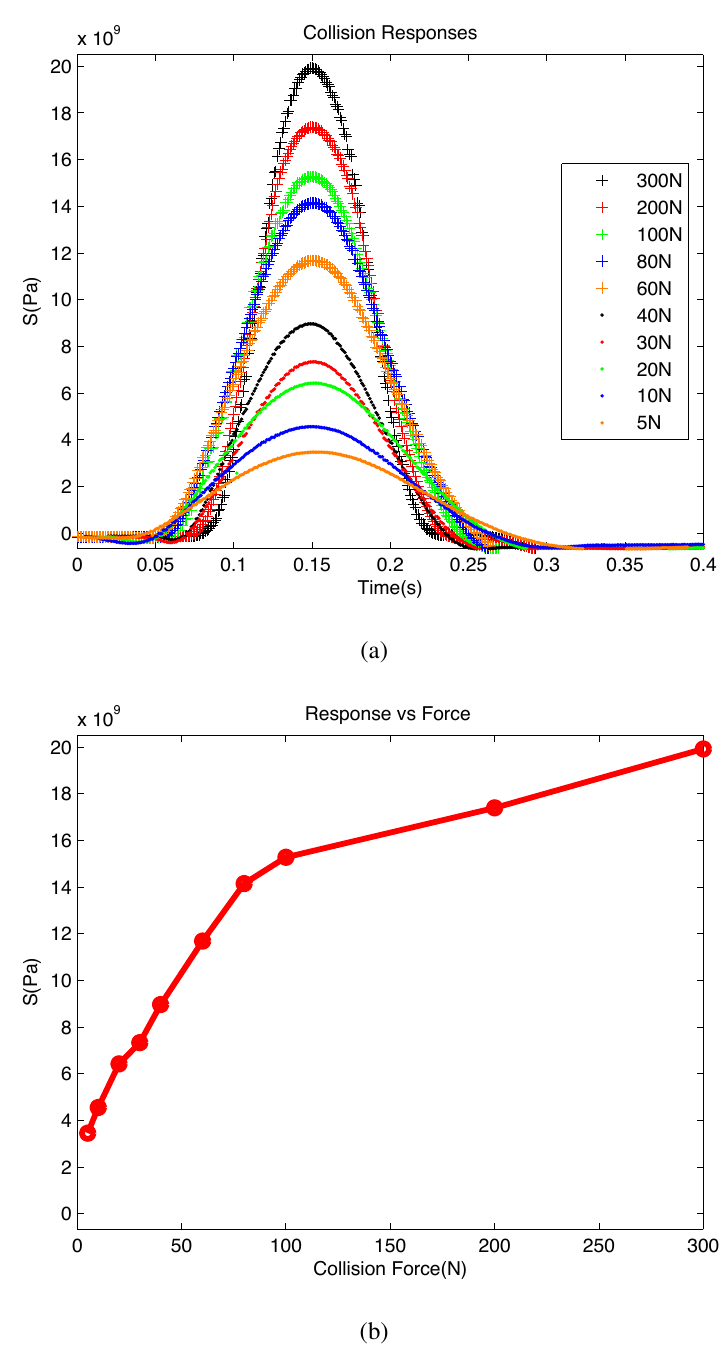
Figure 5. Results from sensor mounted on a non-planar surface. ( a ) Mean captured results for wide dynamic range of collision stimuli; ( b ) The relation of measured collision to force of object